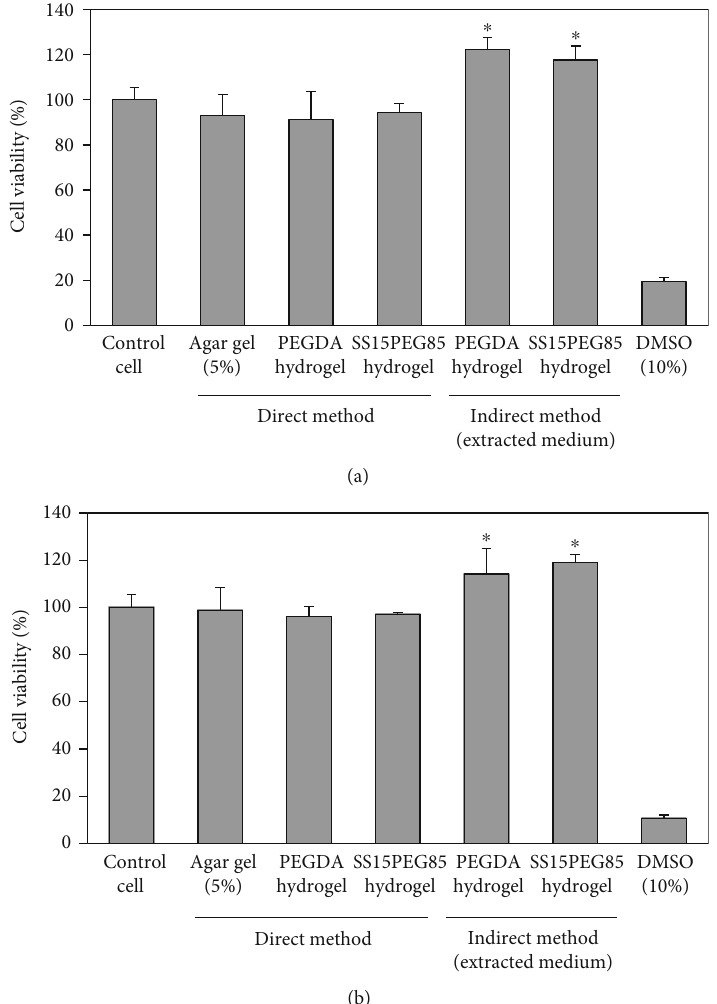
Figure 8: The cell viability by MTS assay using direct and indirect methods ( n = 3 ). The dermal fi broblasts were exposed to SS15PEG85 for (a) 24hr and (b) 48